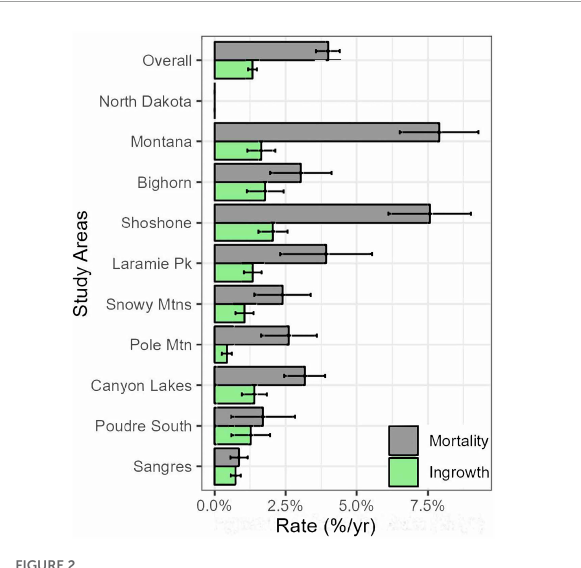
pines (3 to 4% of live stems, respectively). The proportion of live limber stems declined slightly, though not significantly, in all study areas, except Laramie Peak and North Dakota ( Supplementary Table 2 ). Overall, average live tree density (stems ha − 1 ) declined significantly overall for all tree species over the study period ( − 55 ± 25 stems ha − 1 , P = 0.03), and this was most pronounced in the Pole Mountain study area ( − 274 ± 84 stems ha − 1 , P = 0.01; Supplementary Table 4a ). However, while not significant, increases in aspen (Poudre South), spruce-fir (Snowy Mountain and Bighorns), and other pines (Bighorns) were observed ( Supplementary Table 2 ). Live limber pine density also decreased significantly overall from 383 stems ha − 1 in 2004–2007 to 333 stems ha − 1 in 2016–2017 ( − 50 ± 10 stems ha − 1 , P < 0.001). Decreases were greatest on Pole Mountain ( − 139 ± 47 stems ha − 1 ,